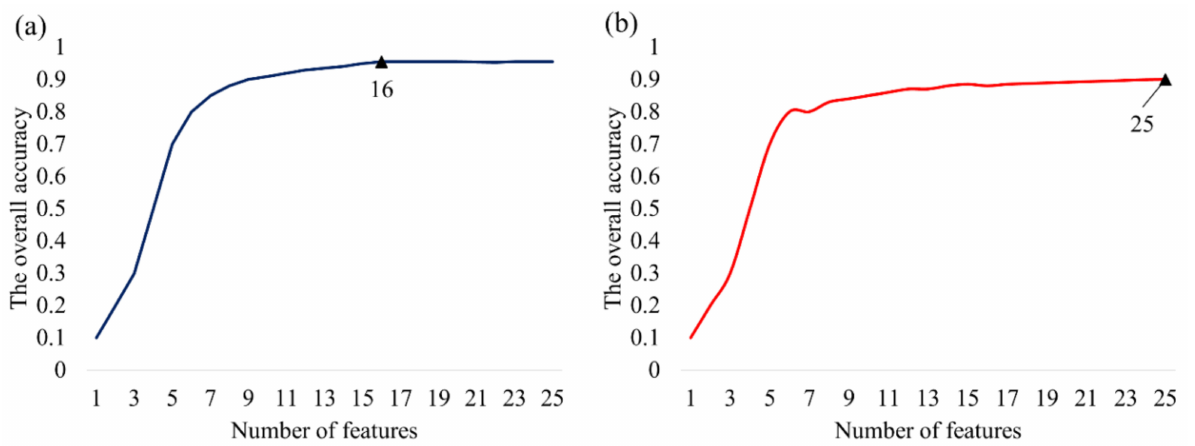
Figure 8. Feature experiment of two classifications: ( a ) the first classification; ( b ) the second